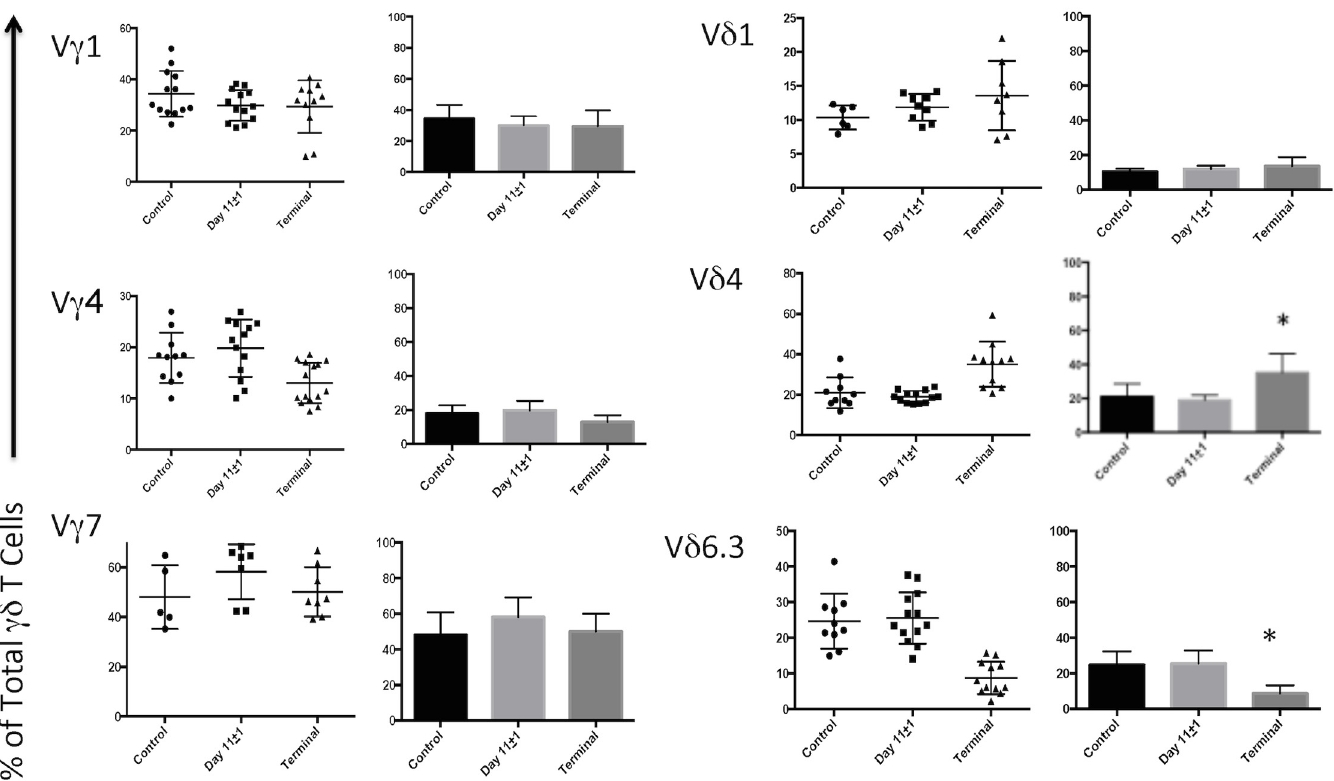
Fig 3. Flow cytometric evaluation of the γδ T cell receptor (TCR) repertoire in control vs. early and late stage tumor-bearing mice (distribution on left panels, x ± SD, right panels, * = p < 0.05). There were no significant changes in the V γ 1, V γ 4, or V γ 7 subsets from controls either post-tumor injection day 11 ± 1 or at end stage. Additionally, there were no changes in the proportions of V δ 1, V δ 4, and V δ 6.3 at day 10. A significant decrease of the %V δ 6.3 population at end stage was offset by a parallel increase in %V δ 4 cells. TCR subsets V γ 3 and V δ 3 were also measured, however, relative proportions were negligible (data not shown)